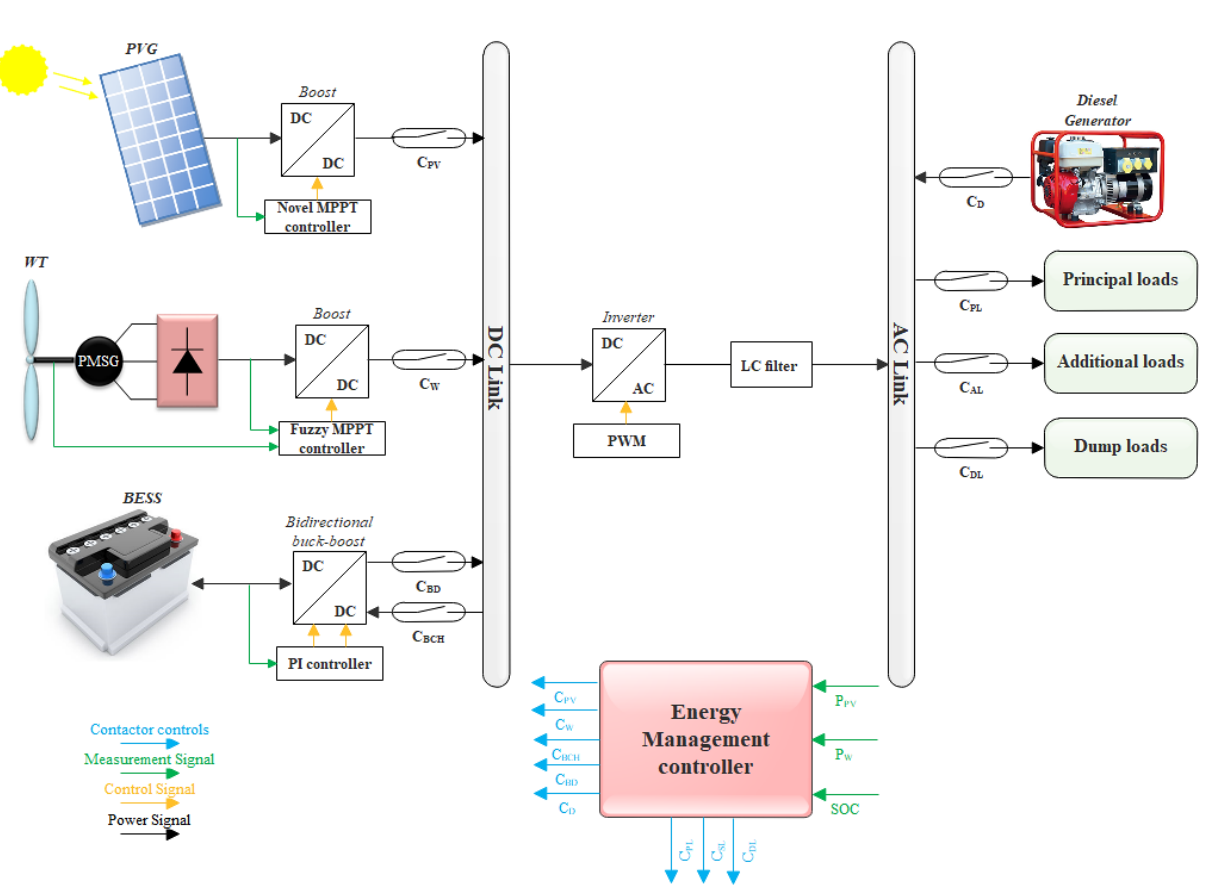
Figure 1. Configuration of the